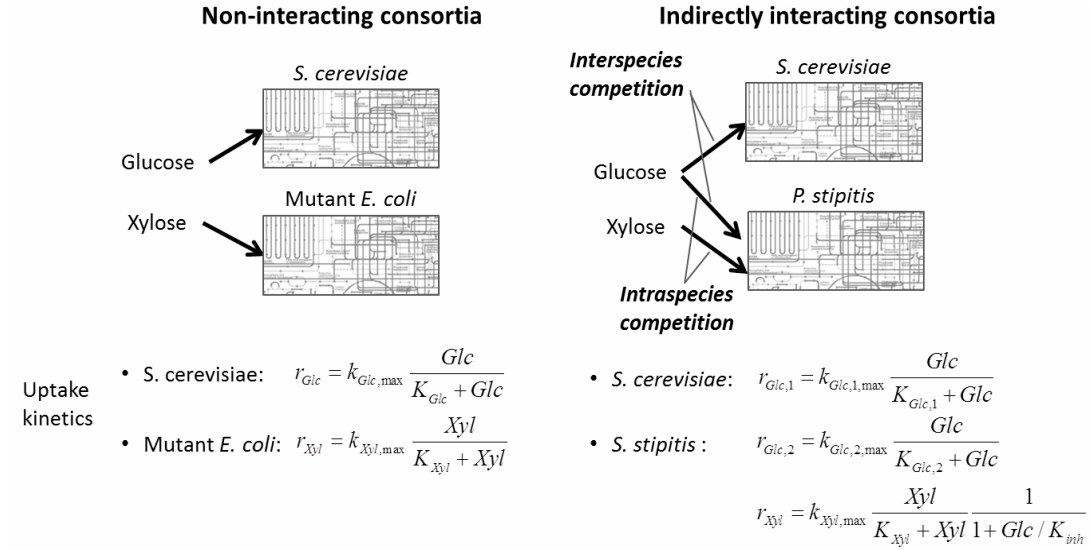
Figure 11. Uptake kinetics for the dynamic FBA (dFBA) simulation of the dynamics of non-interacting ( left ) and indirectly interacting ( right ) consortia. Glc and Xyl denote the concentrations of glucose and xylose, respectively. For the sake of simplicity, product ( i.e. , ethanol) inhibition term is